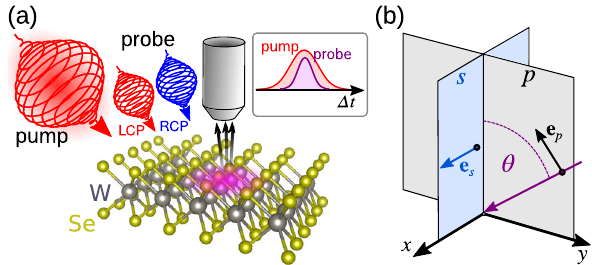
hand circularly polarized (RCP) pump pulse transiently dresses the electronic structure of bulk 2 H -WSe 2 , which is probed by a circularly polarized femtosecond extreme ultraviolet (XUV) pulse. The probe pulse is centered at time delay Δ t = 0 with respect to the peak of the pump pulse. b Geometry of the simulated experiment: the propagation direction of the probe pulse is in the p plane ( x – y plane), rotated by an angle of θ = 65 ∘ with respect to the z axis. The s plane is along the x